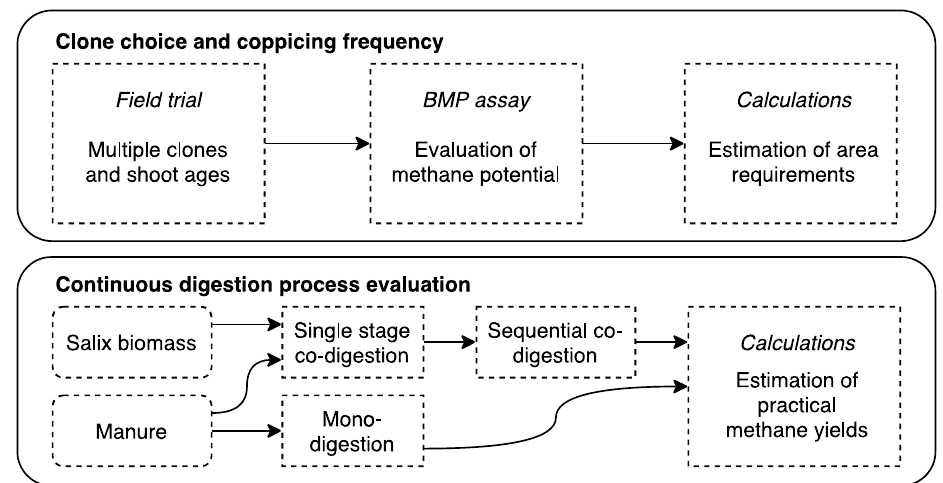
Figure 1. Overview of the experimental steps in this work. BMP: biomethanation potential.